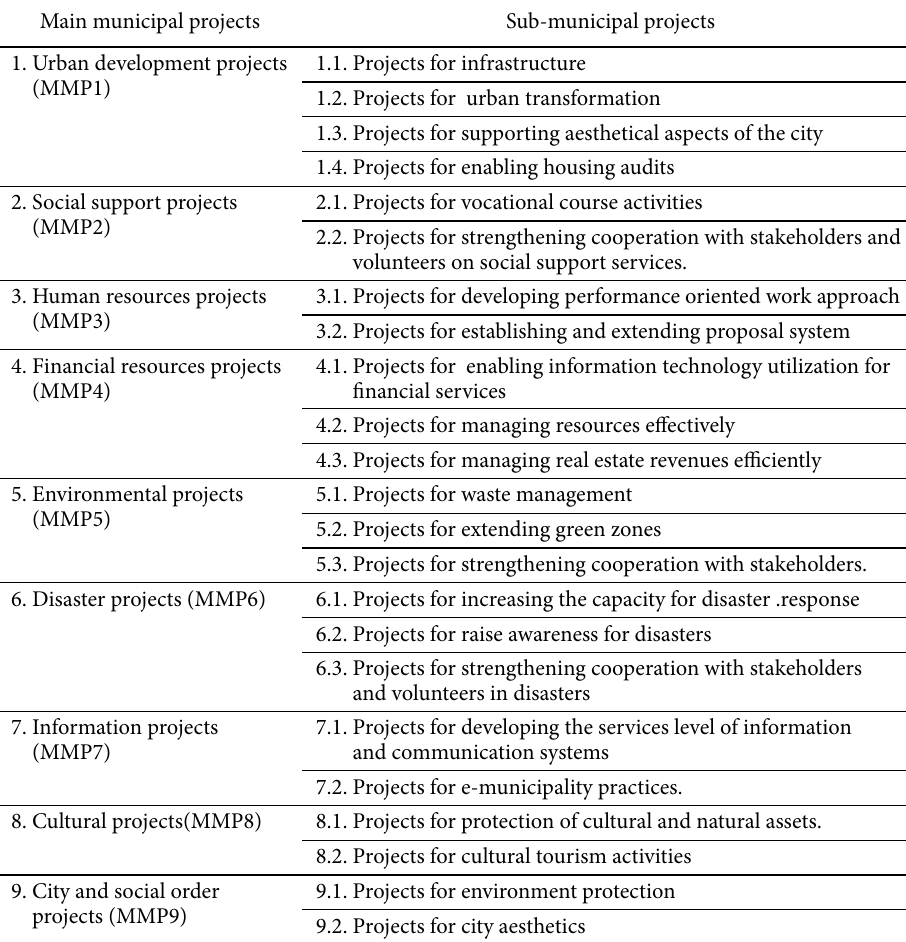
Table 4. Main and sub-municipal projects Main municipal